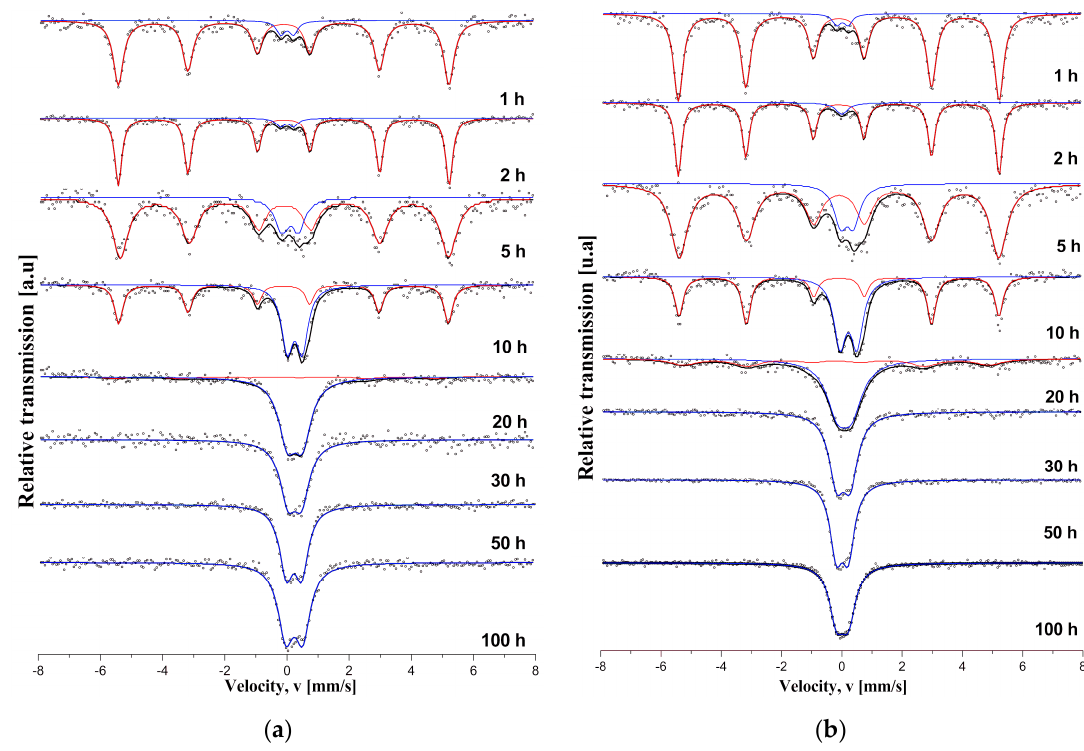
Figure 4. Room temperature Mössbauer spectra as a function of the milling time of: ( a ) Si-free alloy and ( b ) Si-containing alloy samples.